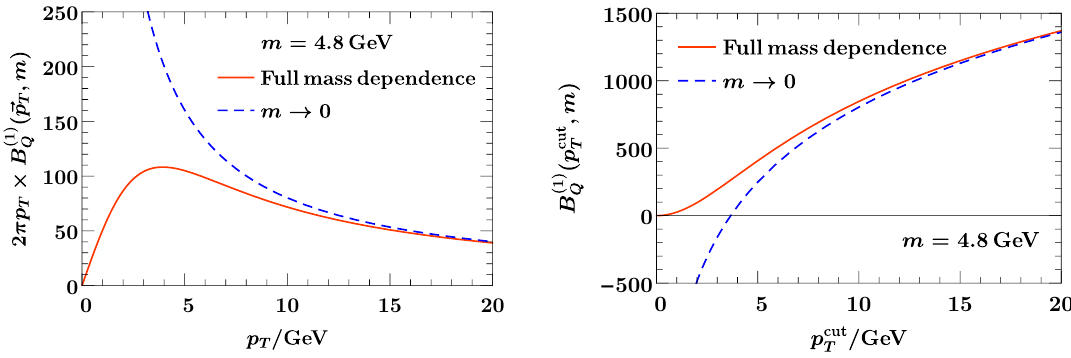
Figure 11 . Massive b -quark beam function (left panel) and its cumulant (right panel) together with its m 0 limit. The input parameters are described in the text. !